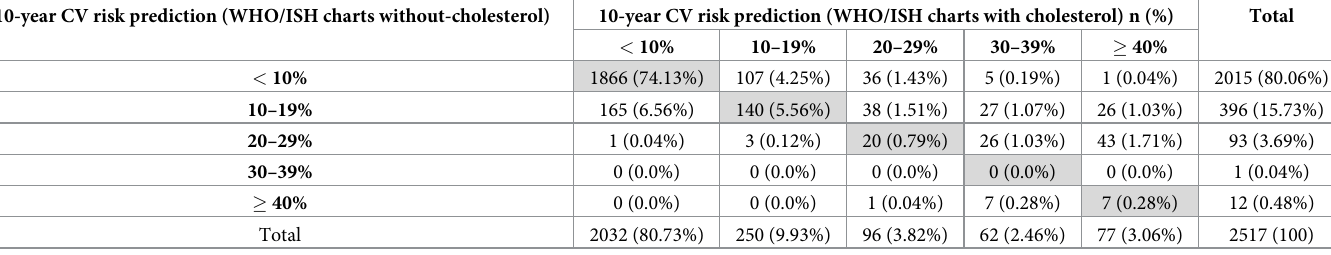
Table 3. Comparison of WHO/ISH 10-year CV risk predictions made using charts with and without cholesterol a . 10-year CV risk prediction (WHO/ISH charts without-cholesterol)